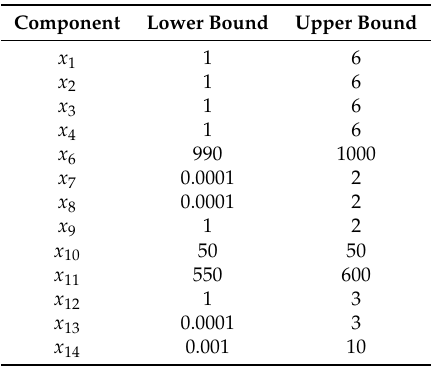
Table 1. The considered domains of variables x when solving